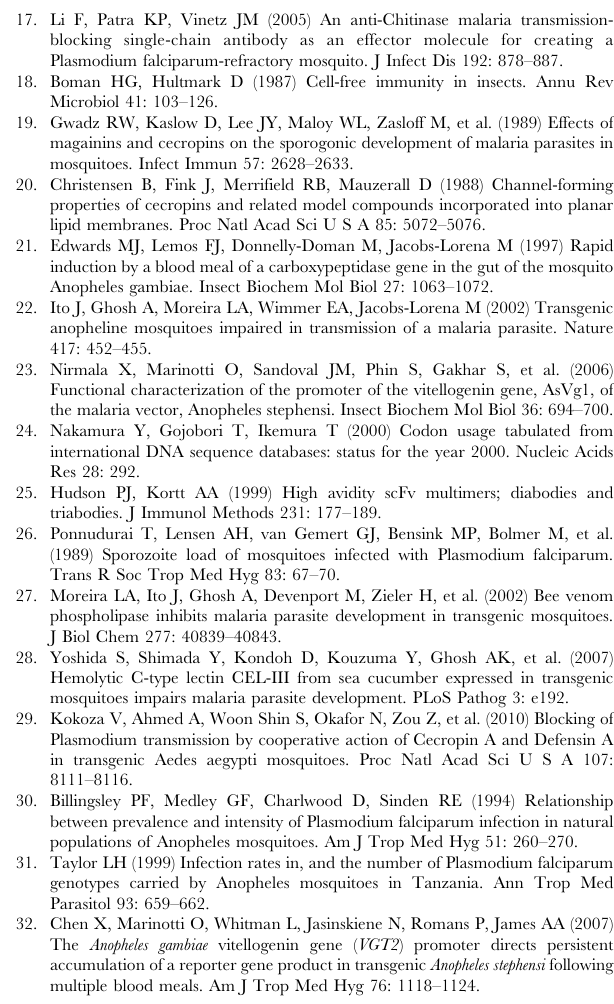
Figure S1 Immunoblot loading controls. Coomassie-stained polyacrylamide gels used in immunoblot analyses of m2A10